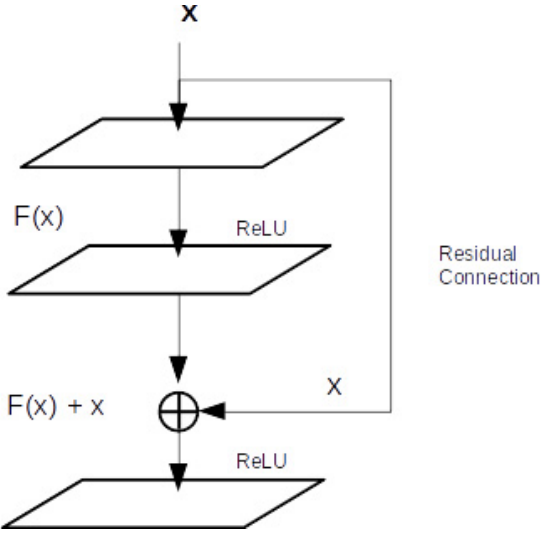
Fig. 17. A block diagram of a residual network.